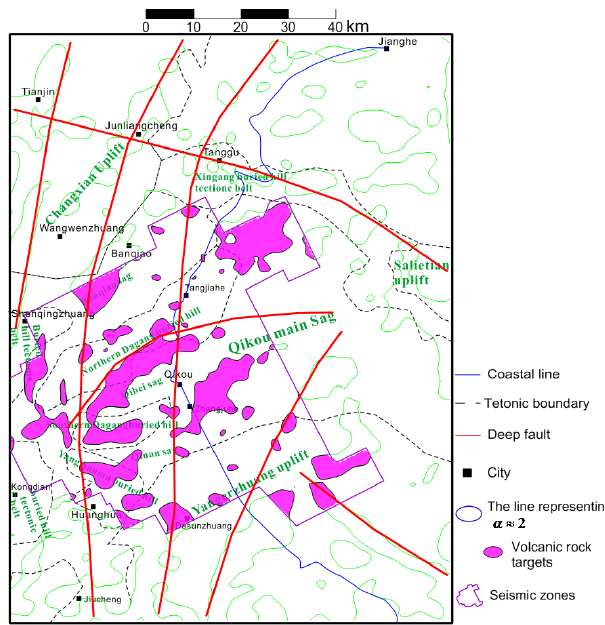
Fig. 13. Potential volcanic rock targets identified from RTP aero- magnetic singularities in the 3-D seismic work area of the Qikou